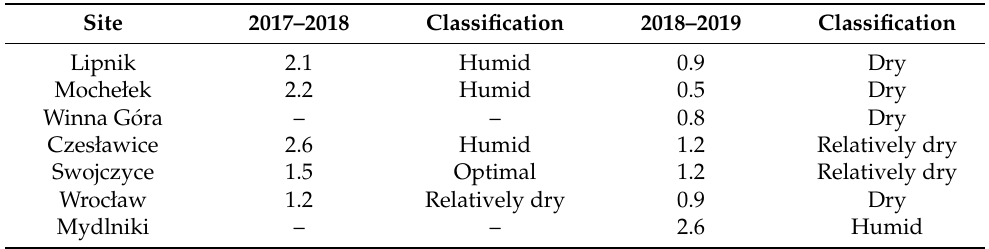
Table 4. Hydrothermal coefficient (K) calculated for the 2017–2018 and 2018–2019 seasons for the study